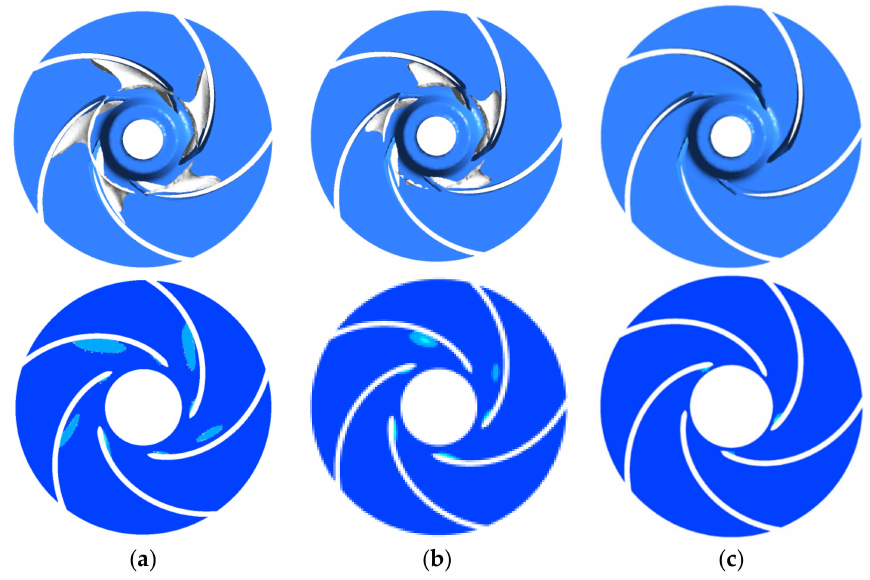
Figure 12. Bubble distribution with different temperatures based on the same. ( a ) T = 25 °C; ( b ) T = 50 °C; ( c ) T = 70